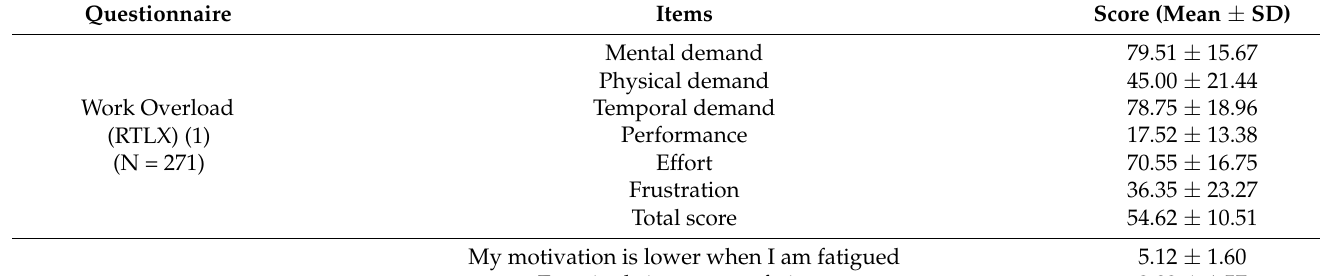
Table 1. Punctuation of each item and the total score for the RTLX, FSS, and ESS questionnaires for the total